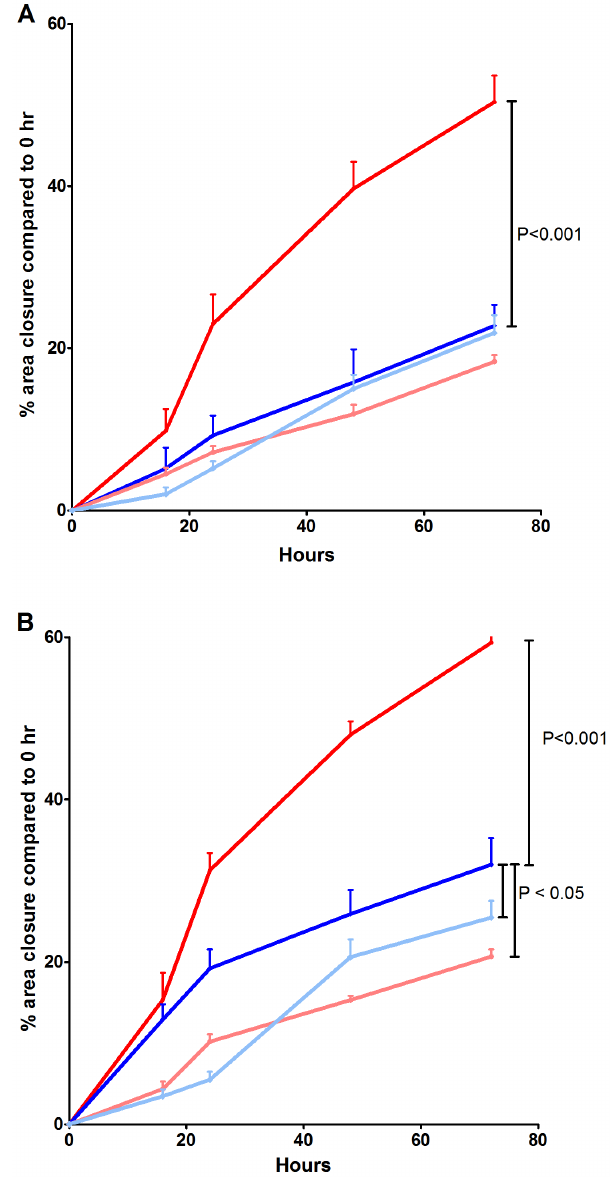
Figure 9. FBLN-1C promotes wound healing in asthmatic ASM cells. The degree of closure, measured over time, of a 1cm wound induced in non-asthmatic (n=6–7) or asthmatic (n=6–7) ASM cells reseeded on an ECM deposited by an asthmatic ASM cell line in the presence (dark red line (asthmatic) and dark blue line (non-asthmatic)) or absence (resulting from treatment with a FBLN-1C AO, light red line (asthmatic) and light blue line (non-asthmatic)) of FBLN-1C. Wound healing rates were measured basally (0.1% BSA) (A) or following stimulation with TGF b (B). Data are expressed as mean 6 SEM.